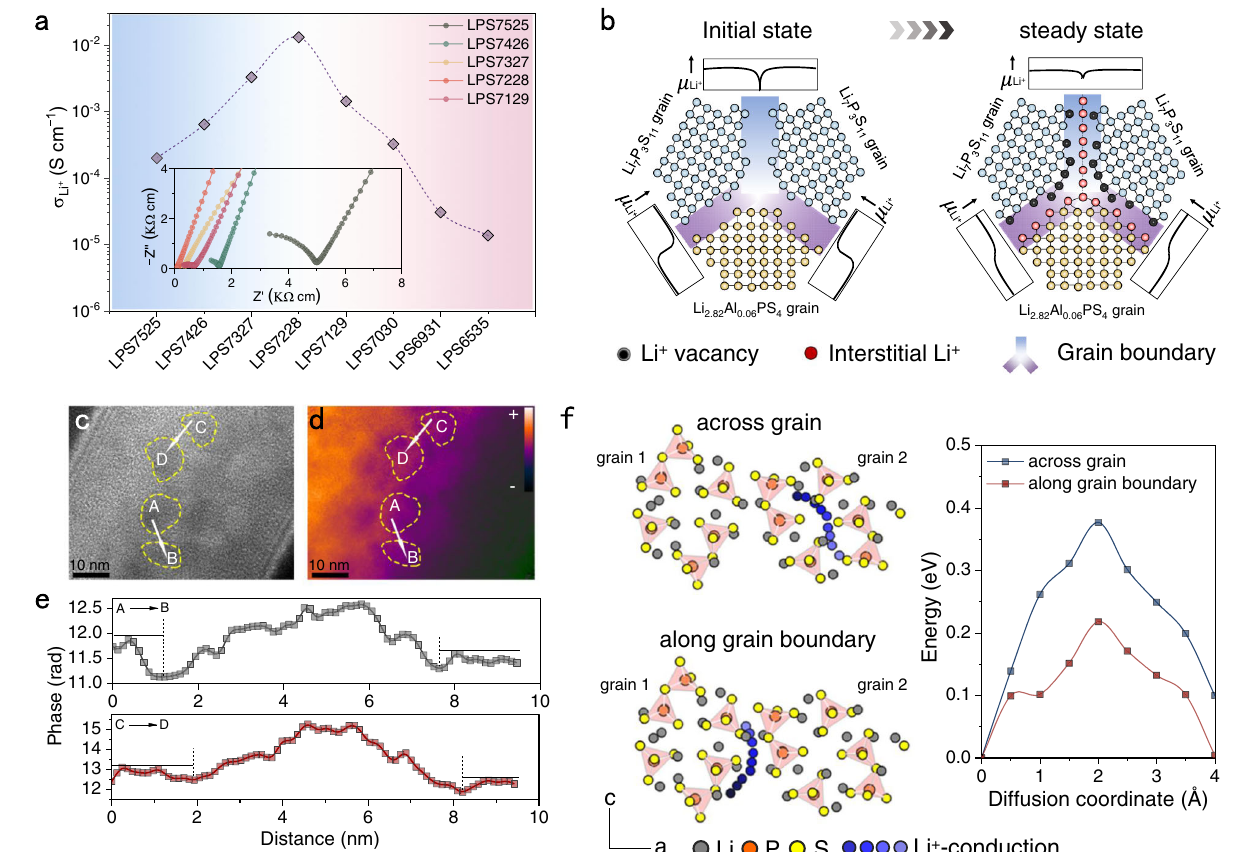
Fig. 3 | The superLi + -conduction. a σ Li + at roomtemperatureof various Al-GCsin thecold-pressedstate.EISplotsareshownintheinset. b Schematicdiagramofthe carrier redistribution within Li 7 P 3 S 11 @Li 2.82 Al 0.06 PS 4 hetero-nanodomain driven by μ Li + . c – e Electron holography observation of LPS7228: c Initial hologram image.